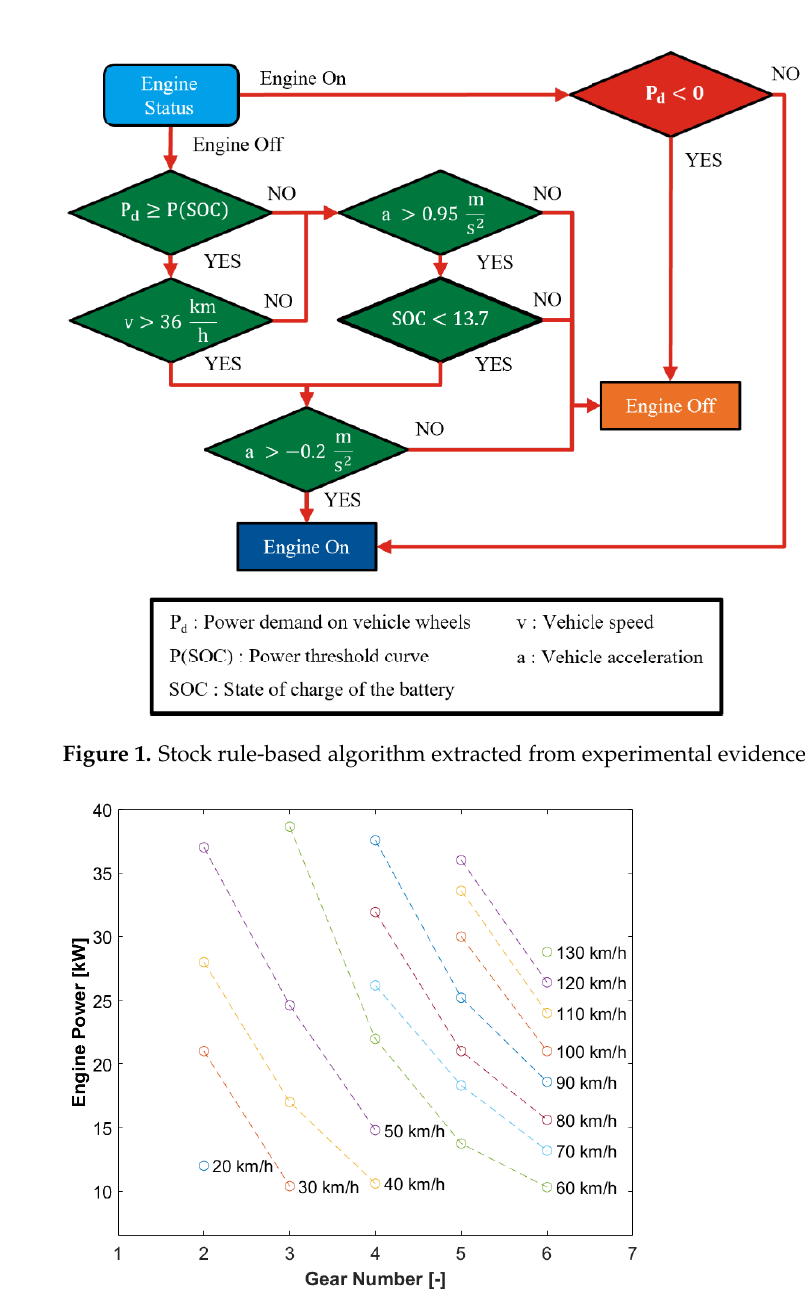
Figure 2. Engine power output decided by the RB algorithm depending on gear and vehicle